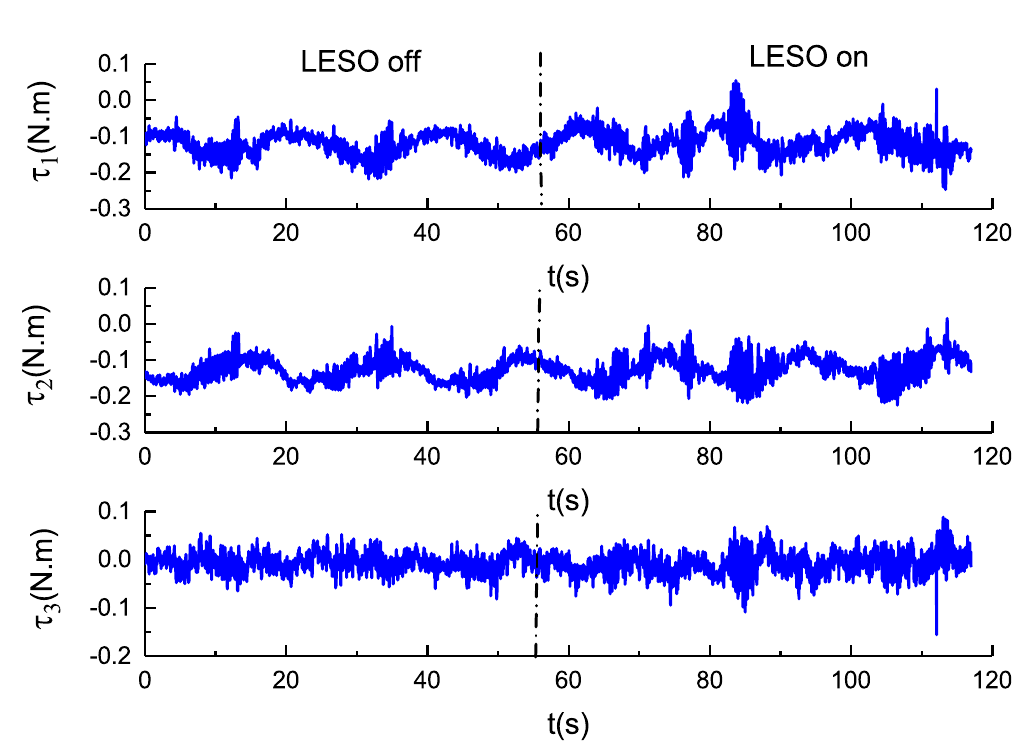
Figure 9. Control torque with the LESO off and on using attitude